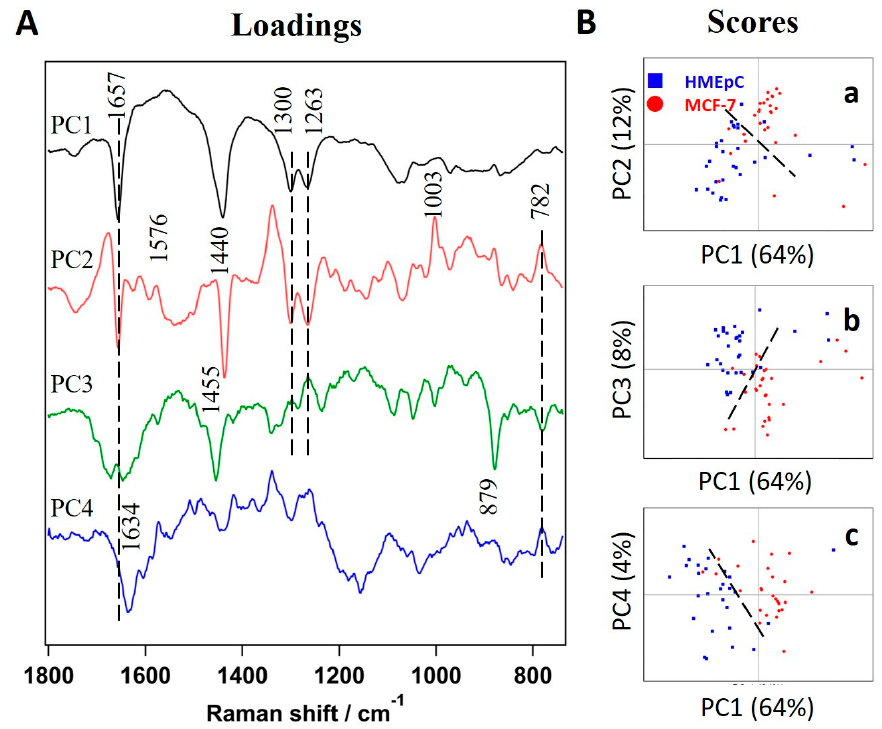
Figure 2. Results of principal components analysis (PCA) analysis. ( A ) First 4 principal components (PC) loadings, PC1 (64 %), PC2 (17%), PC3 (8%), and PC4 (4%). Broken lines show same band positions regardless of positive or negative tendency. ( B ) Scores plots of ( a ) PC2, ( b ) PC3 and ( c ) PC4 vs. PC1, respectively. Broken lines are drawn as visual guides to discriminate HMEpC and MCF-7.